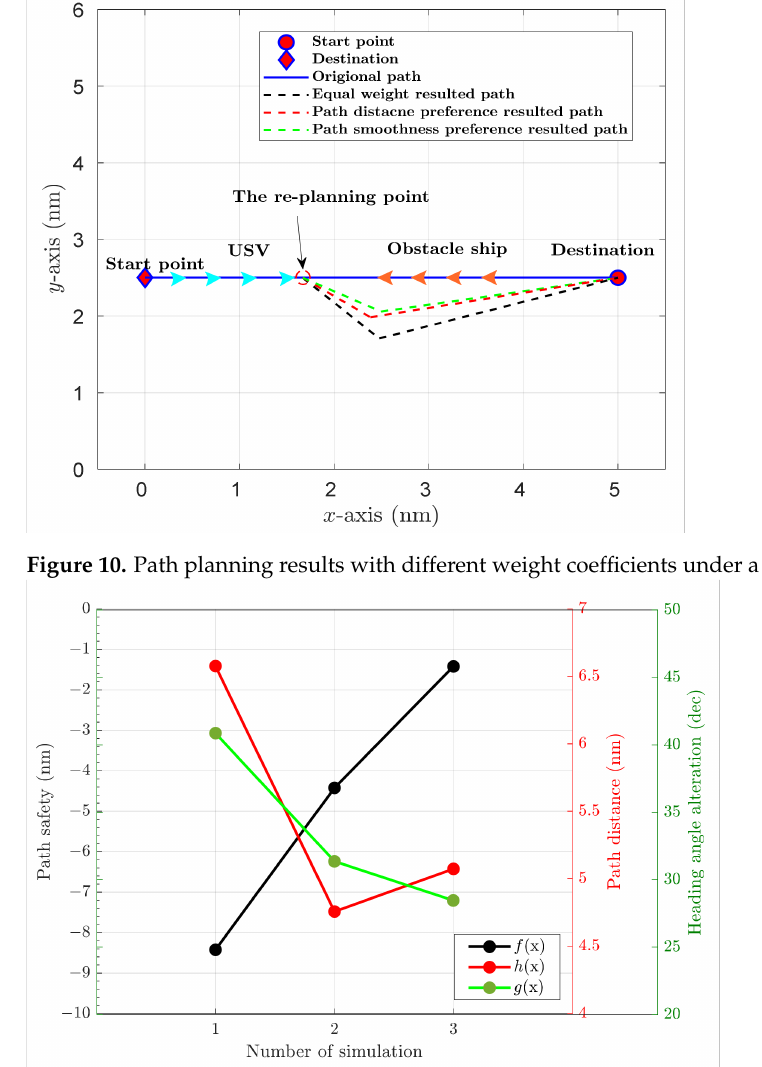
Figure 11. Objective comparison with different weight coefficients ((1) equal weight, (2) path prefer- ence and (3) smoothness